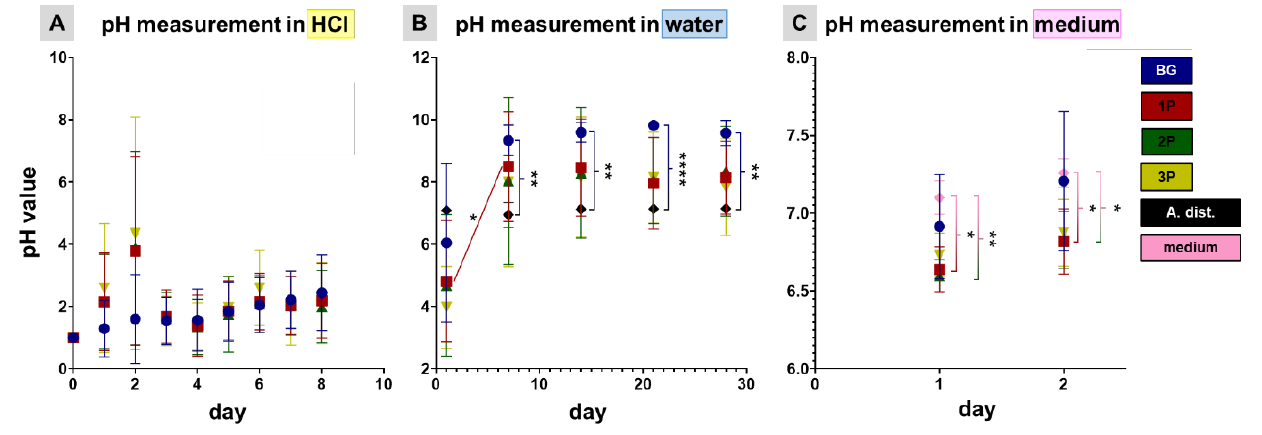
Figure 4. pH measurements in hydrochloric acid (HCl, A ) in water ( B ) and in cell type specific culture medium ( C ). A total of 100 mg of pure bioactive glass scaffold (BG, blue) of single PLGA(1P, red), twofold (2P, green) and threefold PLGA infiltrations (3P, yellow) scaffolds was stored in 1 mL liquid (HCl, Aqua distilled (A. dist.), 10% FCS containing chondrocyte growth medium). The measurement in growth medium was undertaken only for 2 days, since it is normally changed every 2 days. All measurements were performed at RT (22.02 ± 0.11 °C). Significant differences (from four different scaffold batches) were calculated after two-way ANOVA with multiple comparison (*) for p < 0.05; (**) for p < 0.01 and (****) for p < 0.0001.